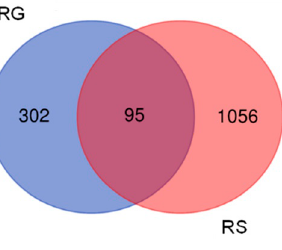
Figure 1. Venn diagrams the number of genes deregulated by RG and RG–RS in the hippocampal neuronal cell line